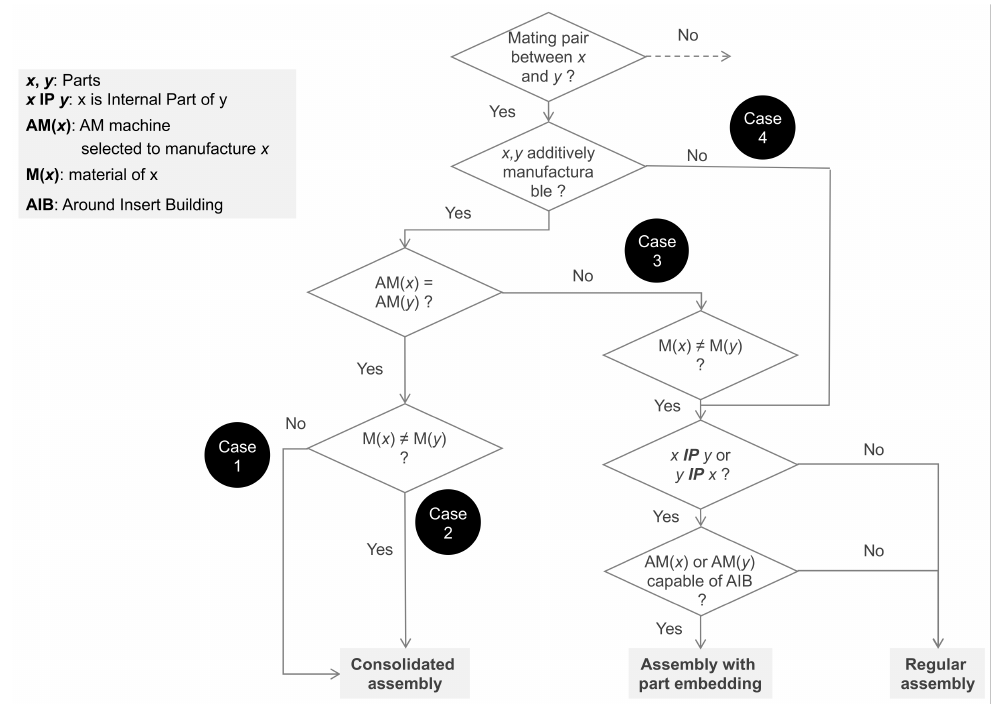
Figure 5. Decision ladder of the product architecture minimization through mating